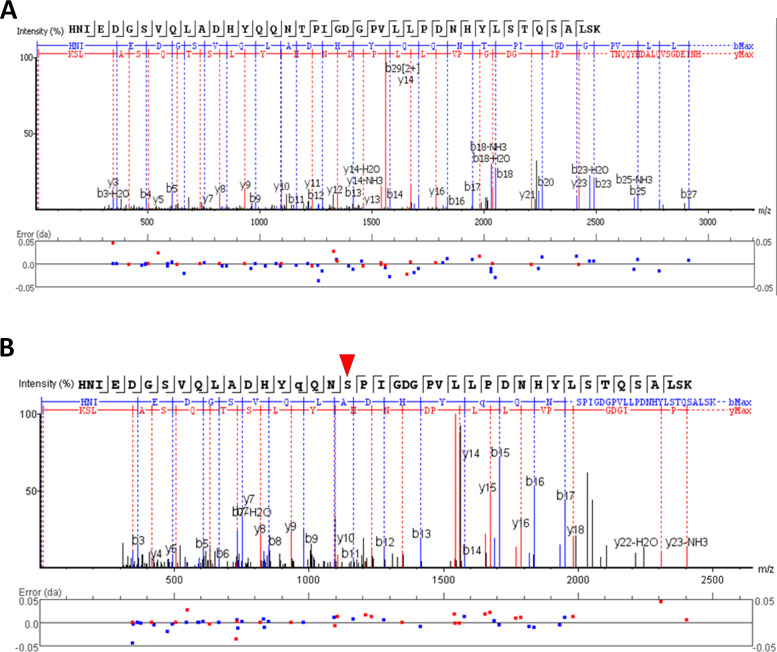
Oxidative stress leads to Thr-to-Ser mistranslation in wild type cells.Mass spectrometry analysis of the reporter protein (GFP) isolated from H2O2-treated wild type HEK293T cells (A) wild type peptide and (B) mutant peptide showing Thr-to-Ser mistranslation.